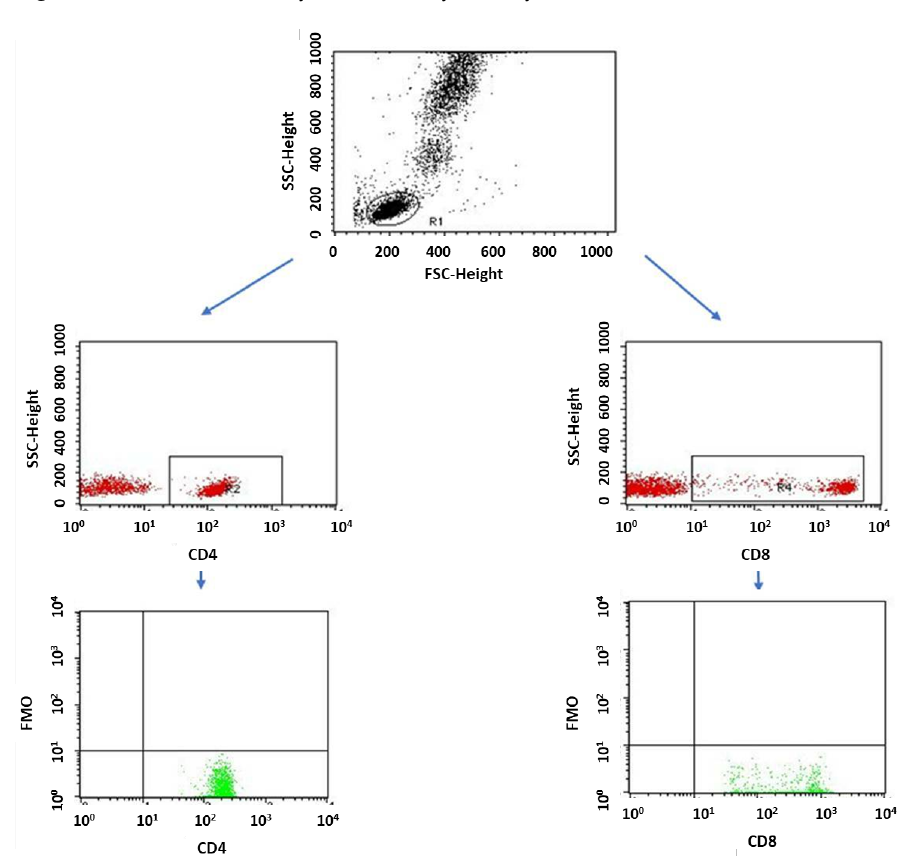
Figure 14. FMO control for cytometric analyses of cytokines.